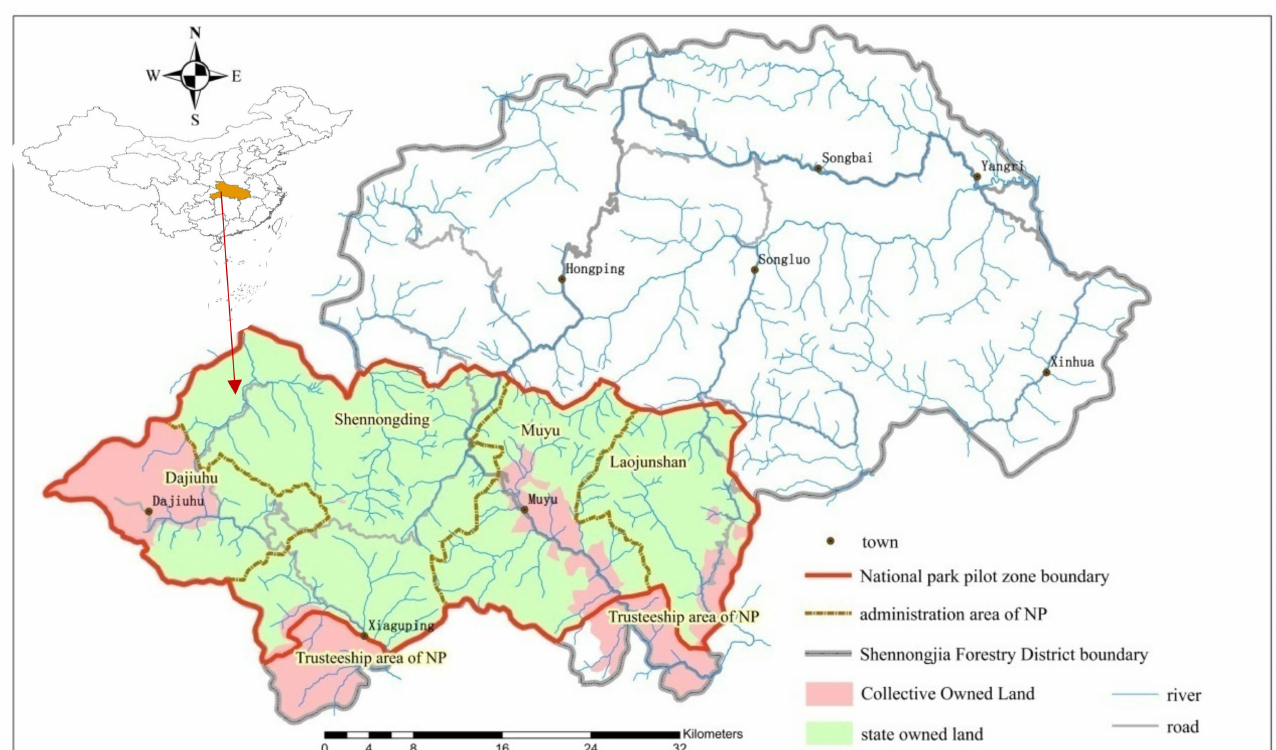
Figure 2. Land ownership of Shennongjia National